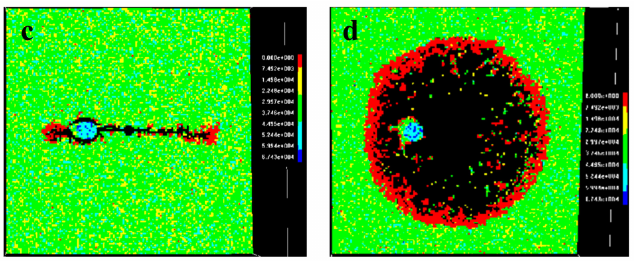
Figure 20. The final HF geometries in Case H and Case I. ( a , b ) correspond to Case H that show the cross section and longitudinal section respectively; ( c , d ) correspond to those of Case